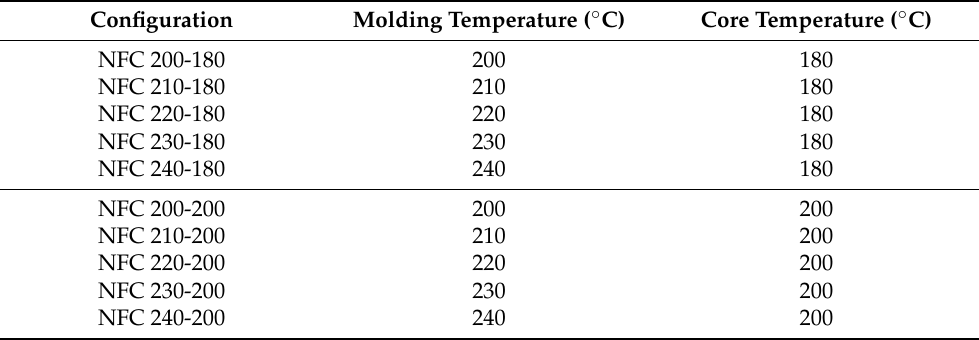
Table 1. Temperature parameters and the different configurations of the natural fiber composite (NFC)